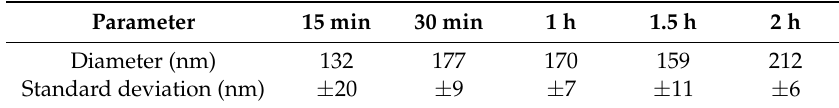
Table 2. Diameters of the electrospun nanofibers.